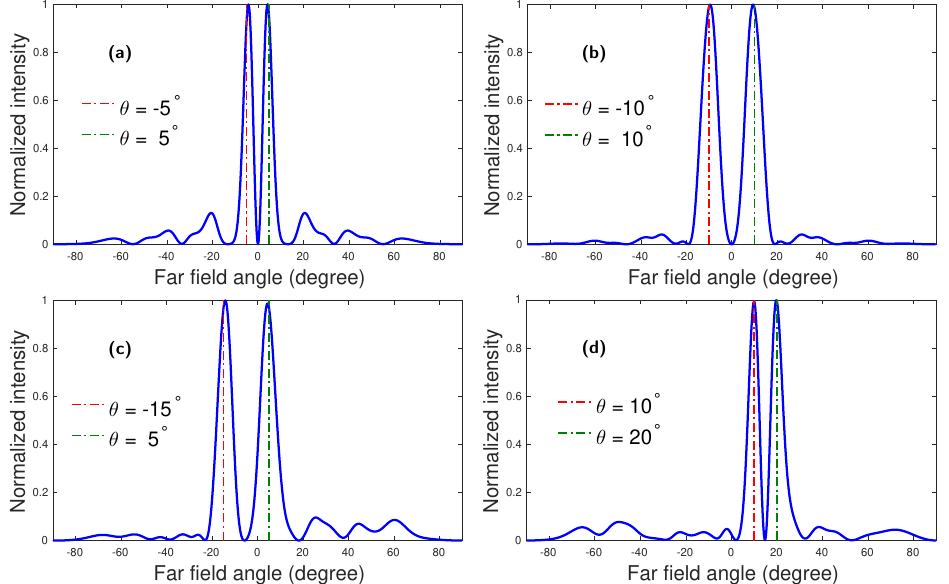
Figure 6. Far-field angular spectrum for optimum dual-beaming effects. The beaming angles are ( a ) ( 5 ◦ ,5 ◦ ) , ( b ) ( 10 ◦ ,10 ◦ ) , ( c ) ( 15 ◦ ,5 ◦ ) , and ( d ) ( 10 ◦ ,20 ◦ ) − − −